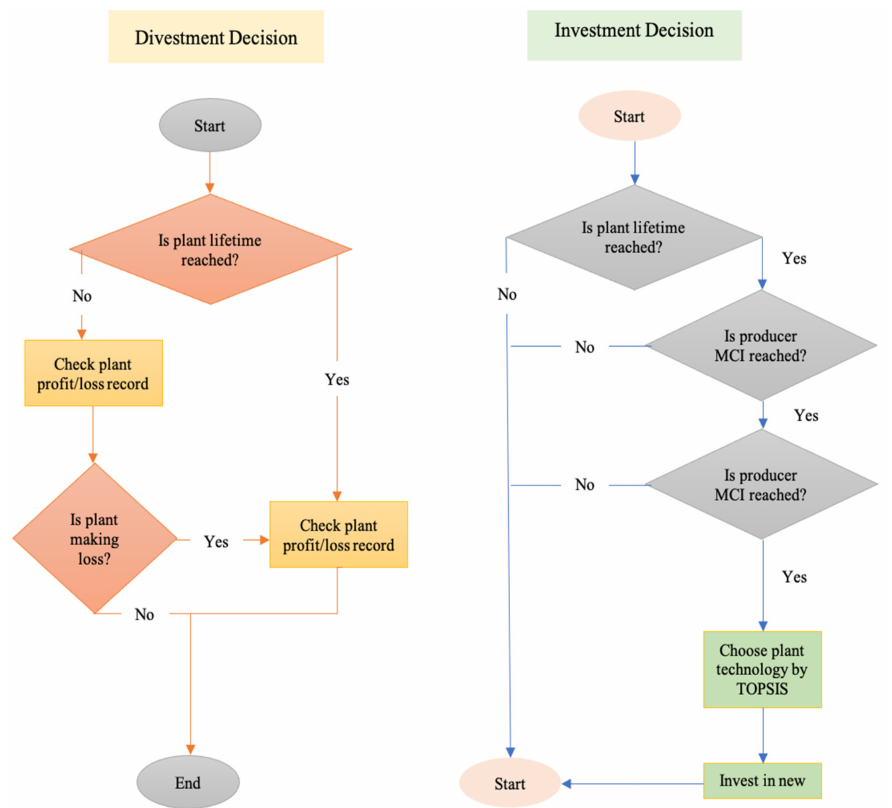
Figure 2. Computational stages of the producer’s investment and divestment activities. Note: The electricity producer starts by checking if the power plant has reached its useful lifetime. If yes,